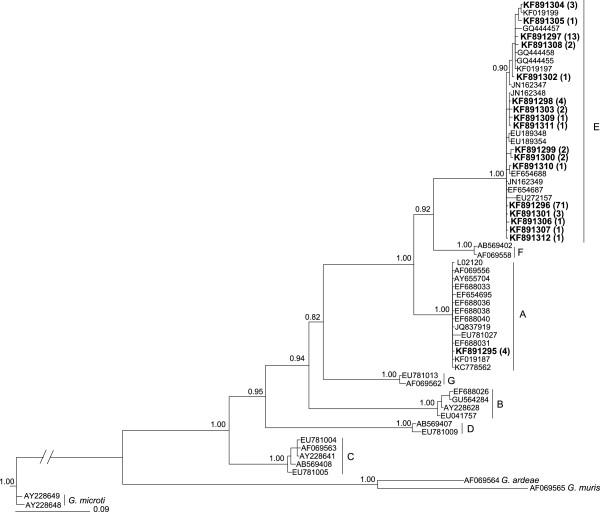
Phylogenetic relationships of ptpi sequences of Giardia duodenalis based on Bayesian inference (BI) analysis. Sixteen sequences determined in the present study, and 41 reference sequences representing G. duodenalis assemblages A to G (accession nos. listed in Additional file 4) were included in the analysis. Sequences representing G. ardeae, G. muris and G. microti were used as outgroups. Accession numbers linked to sequences determined in the present study are in bold-type; the numbers of samples with particular sequence types are in parentheses. Posterior probabilities (pp) are indicated at all major nodes.